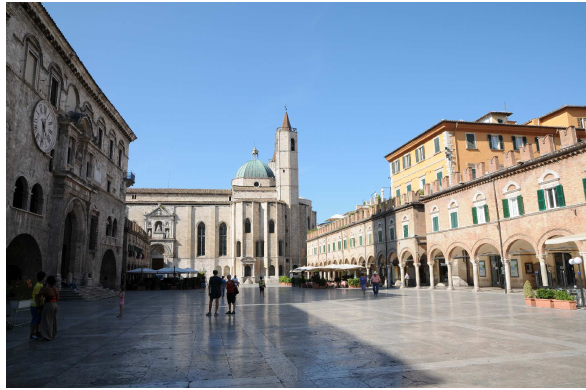
Figure 2. Piazza del